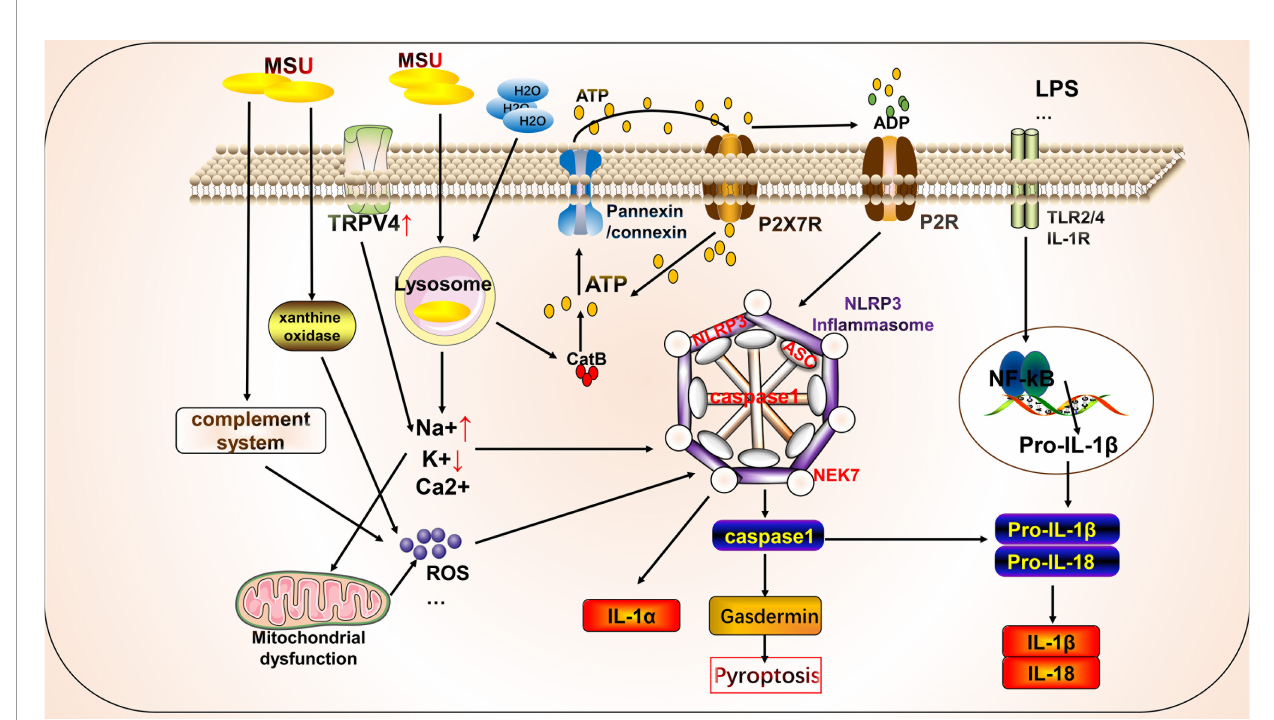
FIGURE 1 | Mechanism of activation of key molecules for pyroptosis by monosodium urate (MSU) in gout. MSU can activate key molecules involved in pyroptosis, such as NLRP3 in fl ammasome, and promote the release of IL-1 b through various mechanisms. MSU-stimulated destabilization of lysosomes leads to the release of cathepsin, which activates the NLRP3 in fl ammasome by regulating ATP metabolism through the cell surface pannexin/connexin channels and purinergic receptors. In addition, MSU can regulate intracellular ion concentrations and mitochondrial function, leading to the release and production of substances, such as ROS, to activate the NLRP3 in fl ammasome. The complement system, particularly the lectin system, is also partially involved in the activation of the NLRP3 in fl